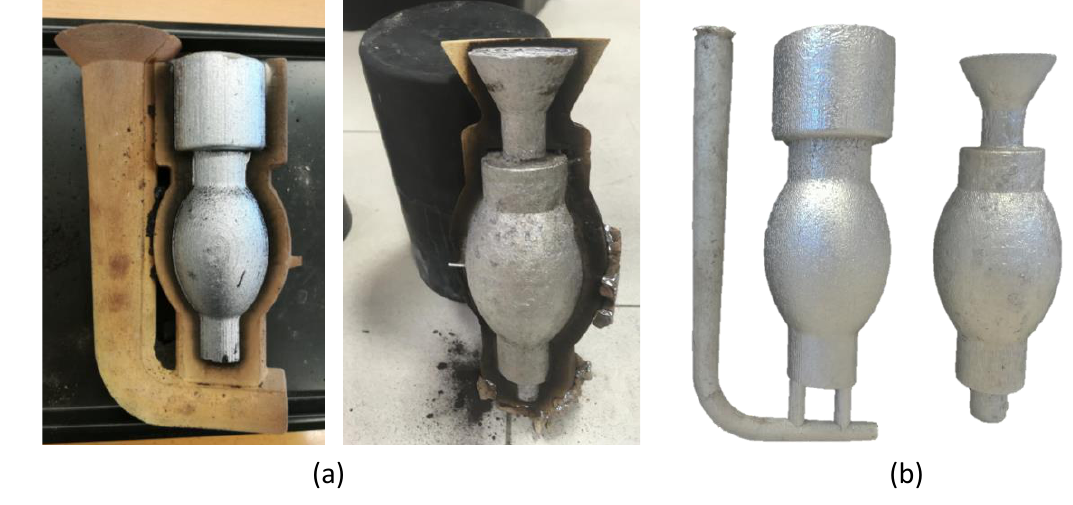
Figure 5. ( a ) Extraction process, ( b ) casting parts.